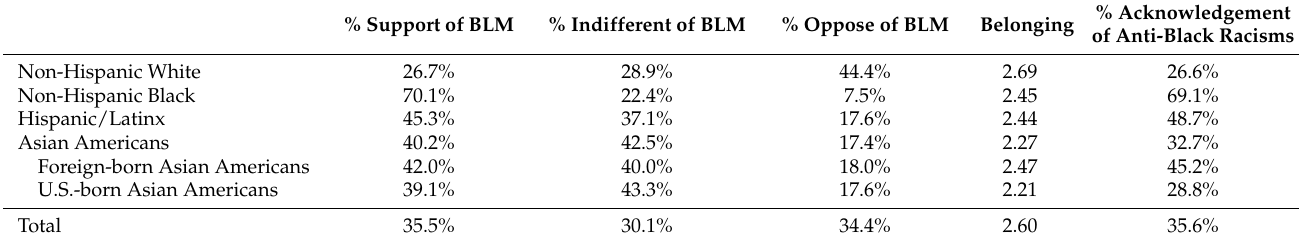
Table 1. Distributions of supporting BLM, belonging, and acknowledgement of anti-Black racism across racialized groups. Source: 2016 Collaborative Multiracial Post-election Survey (CMPS). Note: Statistics are weighted to produce the nationally representative estimates to 2015 U.S. population. Estimates are based on 10,144 individuals including 1034 Non-Hispanic White; 3102 Non-Hispanic Black; 3002 Hispanic/Latinx; and 3006 Asian American adults in 2016 CMPS. % Acknowledgement % Support of BLM % Indifferent of BLM % Oppose of BLM Belonging of Anti-Black Racisms Non-Hispanic White 26.7%